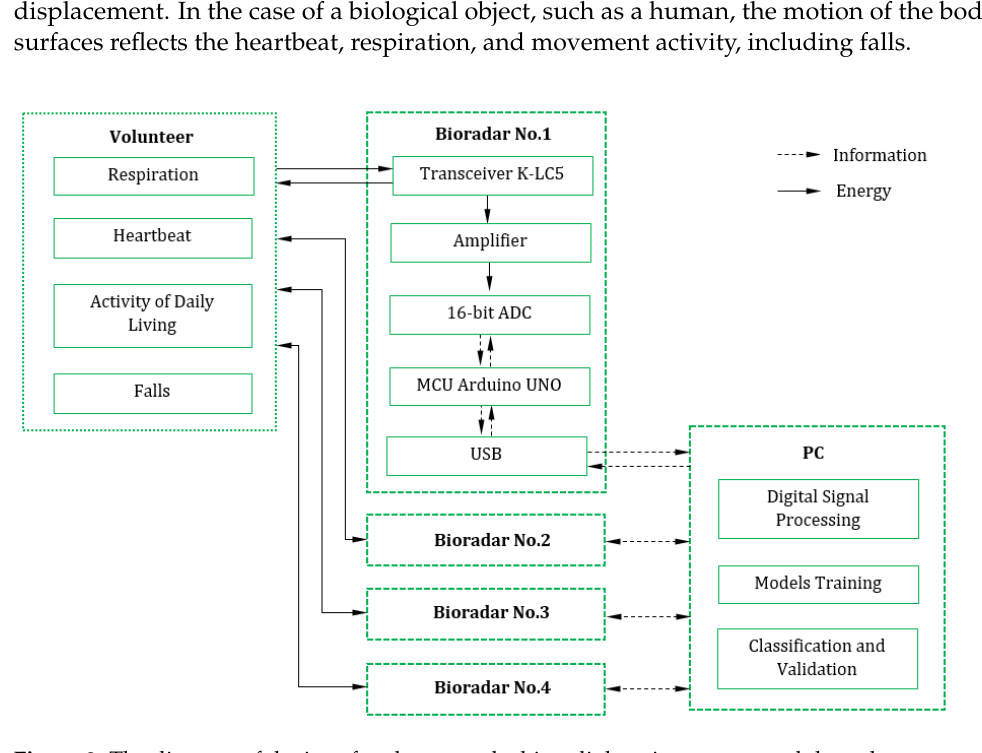
Figure 2. The diagram of the interface between the bioradiolocation system and the